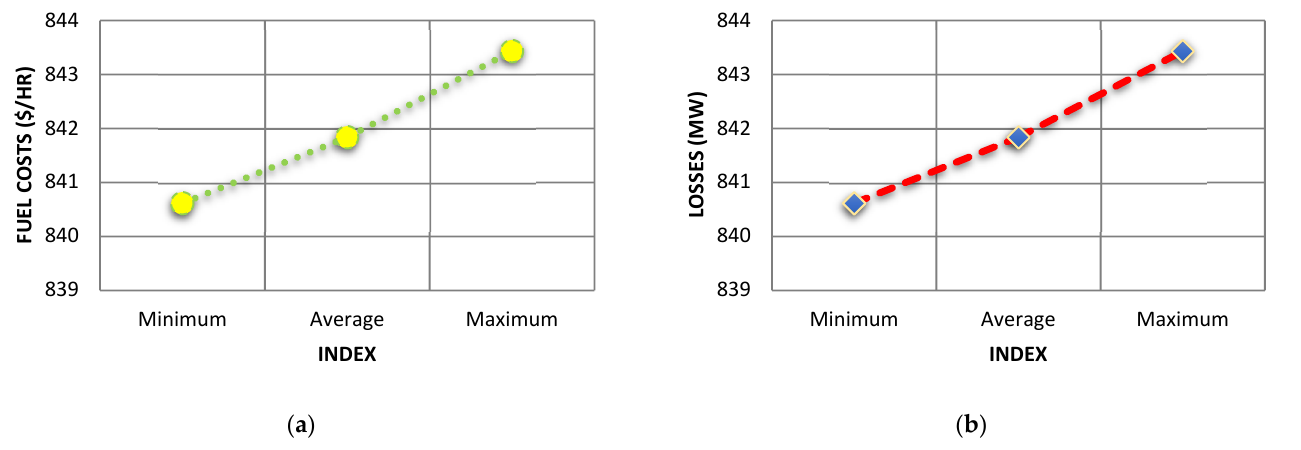
Figure 7. Statistical analysis curves of TLBA for the first system. ( a ) Instance 1; ( b ) Instance 2. For the modified IEEE 57-bus AC-DC network, the minimum, mean and maximum of the objectives obtained for the proposed TLBA are described in Figure 8. As shown, the proposed TLBA has superior performance. For minimizing the TFCs, the proposed TLBA obtains small values of the indices of minimum, mean and maximum of the TFCs of 41894.89, 41929.594 and 41981.34, respectively. For minimizing the ETLs, the proposed TLBA obtains small values of the indices of minimum, mean and maximum of the ETLs of 15.6711, 16.0413 and 16.637, respectively. For both studied cases, the proposed TLBA showed very small standard deviation of 24.99 $/h and 0.3182 MW. This suggests a significantly robust performance of the enhanced TLBA.